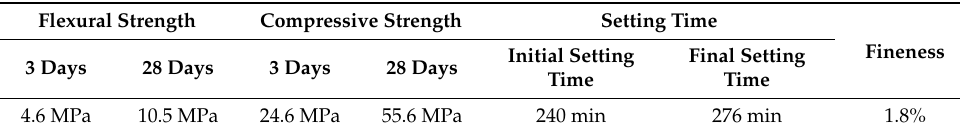
Table 3. Physical and mechanical properties of cement.